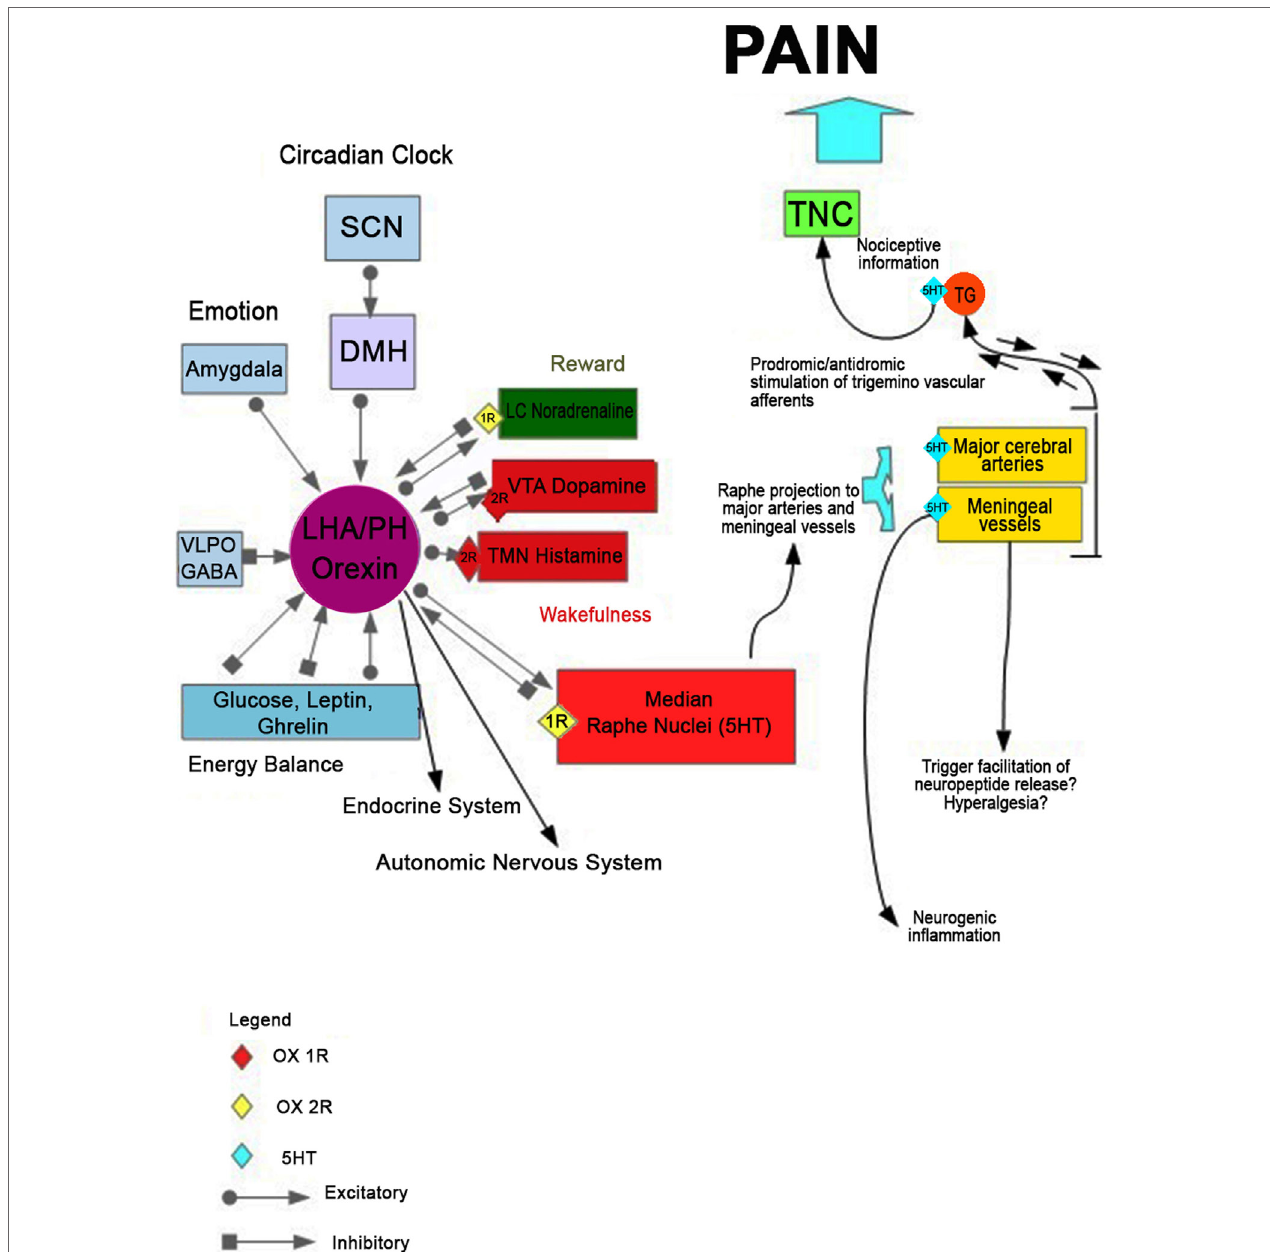
FiGUre 1 | The hypothetical mechanism leading to the onset of migraine pain and disorder of the sleep/wake cycle. Disruption of orexinergic neurons would lead, acting on the serotonergic neurons of the raphe nuclei, to a massive release of serotonin from the median raphe nucleus. It could activate the serotonergic receptors located on the walls of large cerebral vessels, determining an abnormal vasodilatation and increasing transmural pressure. This process could trigger trigeminal nerve terminal that innervates the vascular wall, with consequent antidromal stimulation of sensory nerve endings at the level of hard vessels in the meninges, releasing the pro-inflammatory peptides (substance P and calcitonin gene-related peptide). Within this hypothetical scheme, serotonin released may also interact with trigeminovascular afferents to activate and/or facilitate the release of the neuropeptide at the level of the meningeal vessels trigeminal ganglion. The consequent dysregulation of the physiological negative feedback of serotonin on the orexinergic neurons would contribute to an altered modulation of the whole system, which can alter the sleep–wake cycle.